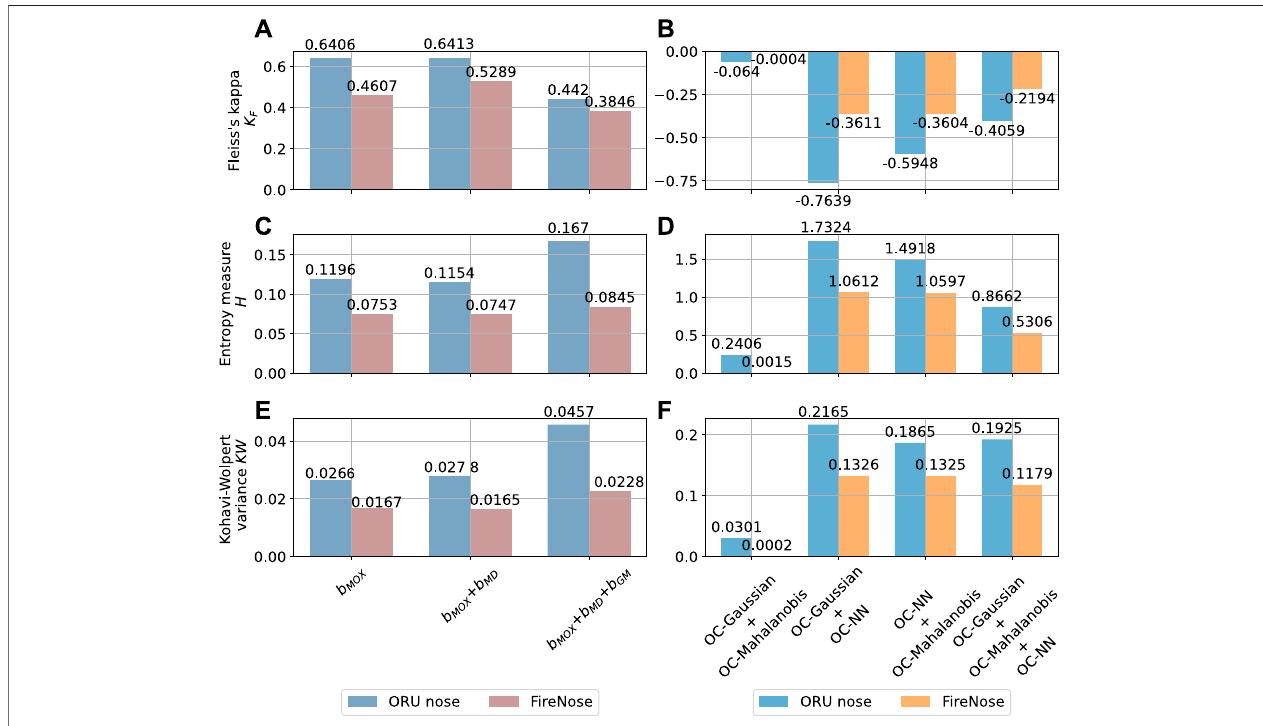
FIGURE 11 | The change of the diversity before and after using model ensemble. The diversity is estimated with the Exp. 3-source trial using FireNose and ORU nose.Eachbarcorrespondstothediversitymeasureofamodelcombination.Thecompositionofeachcombinationcanbefoundinthemaintext. (A,C,E) Thevaluesof Fleiss ’ Kappa K F ,entropymeasure H andKohavi-Wolpertvariance KW ofeachbaseboutdetectionmodelcombinationfortheFireNoseandtheORUnose. (B,D,F) The values of Fleiss ’ Kappa K F , entropy measure H and Kohavi-Wolpert variance KW of each one-class model combination for the FireNose and the ORU nose. The improvements of ensemble diversity are indicated by lower K F , higher H and higher KW